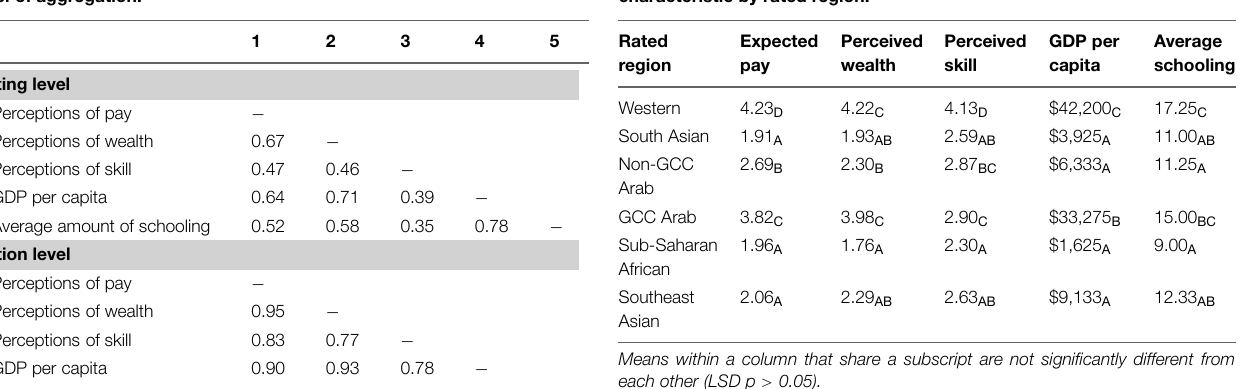
TABLE 3 | Means and homogenous subsets of perceived and actual nation characteristic by rated